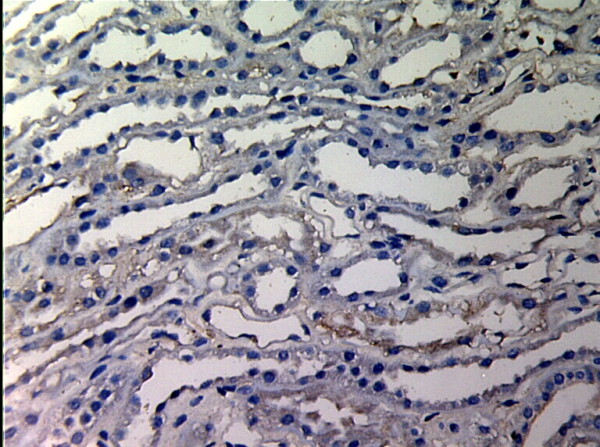
MMP-2 expression in renal tissue with different degree of inflammatory infiltration(EnVision assay; original magnification × 200). Control group.